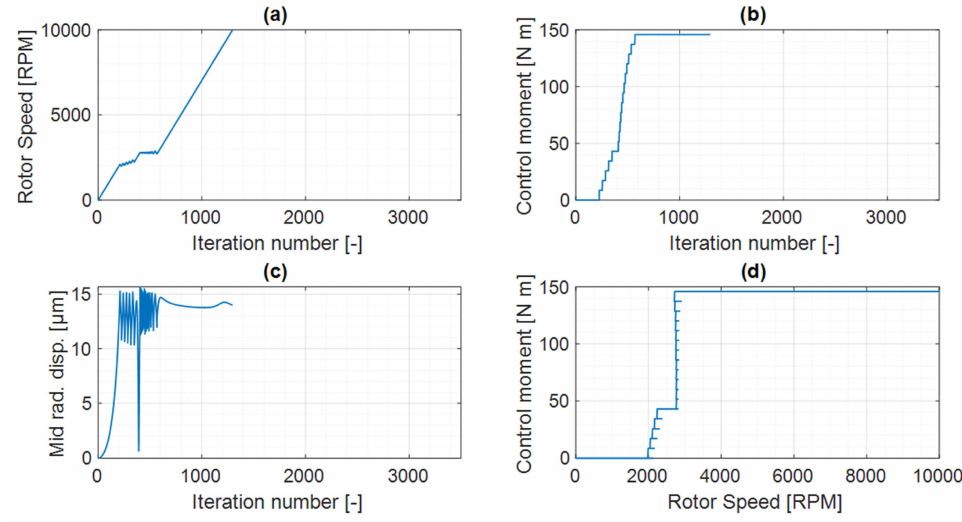
Figure 15. Path taken by the algorithm to optimise the actuator moment using the adjusting metric ap- proach ( a ) Rotor speed at each iteration ( b ) Actuator moment at each iteration ( c ) Radial displacement at each iteration ( d ) Actuator moment at each speed.